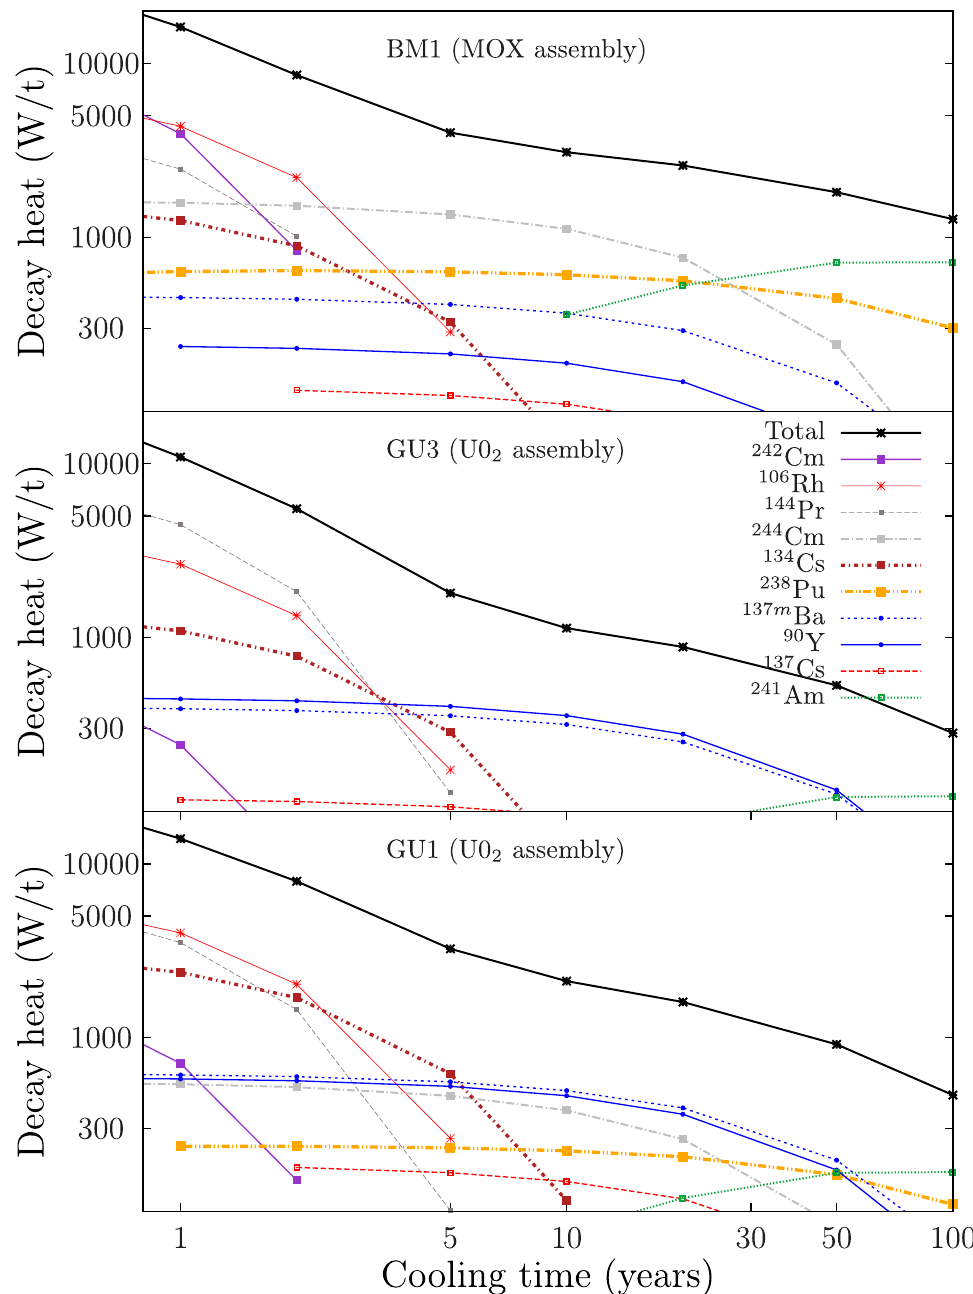
Fig. 6. Total decay heat for the MOX (this work) and two UO 2 assemblies [5,6] containing the samples. The main contributors are also